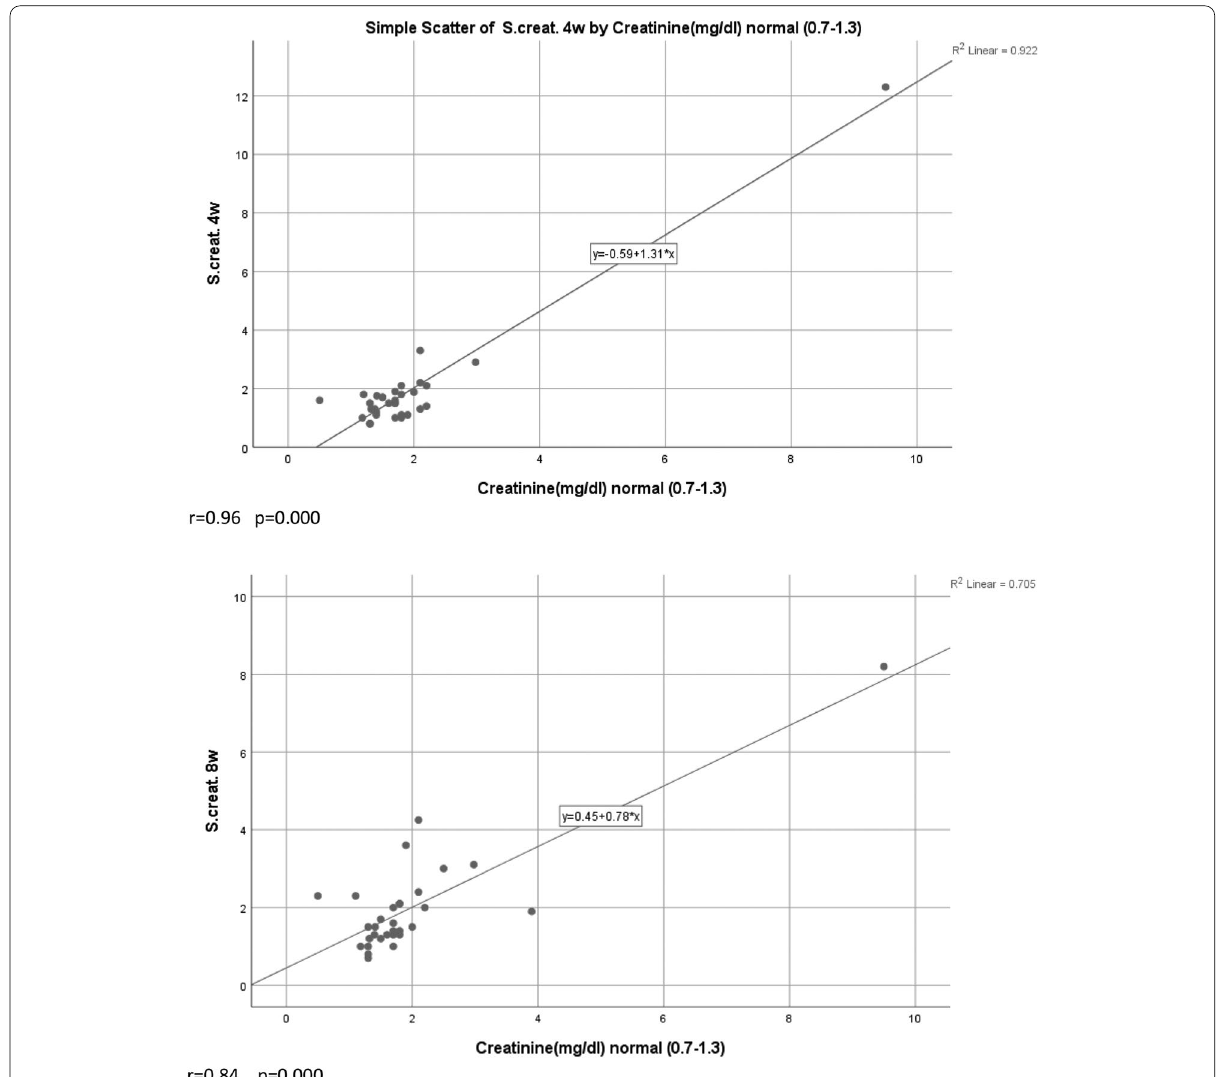
Fig. 1 Correlation between creatinine levels before and during treatment (weeks 4 and 8) in patients not on hemodialysis. Legend: 4 weeks ( r 0.96, P < 0.001) and 8 weeks ( r 0.84, P < 0.001) of follow‑up serum creatinine (s.creat) levels in CKD patients not on hemodialysis ( n = =